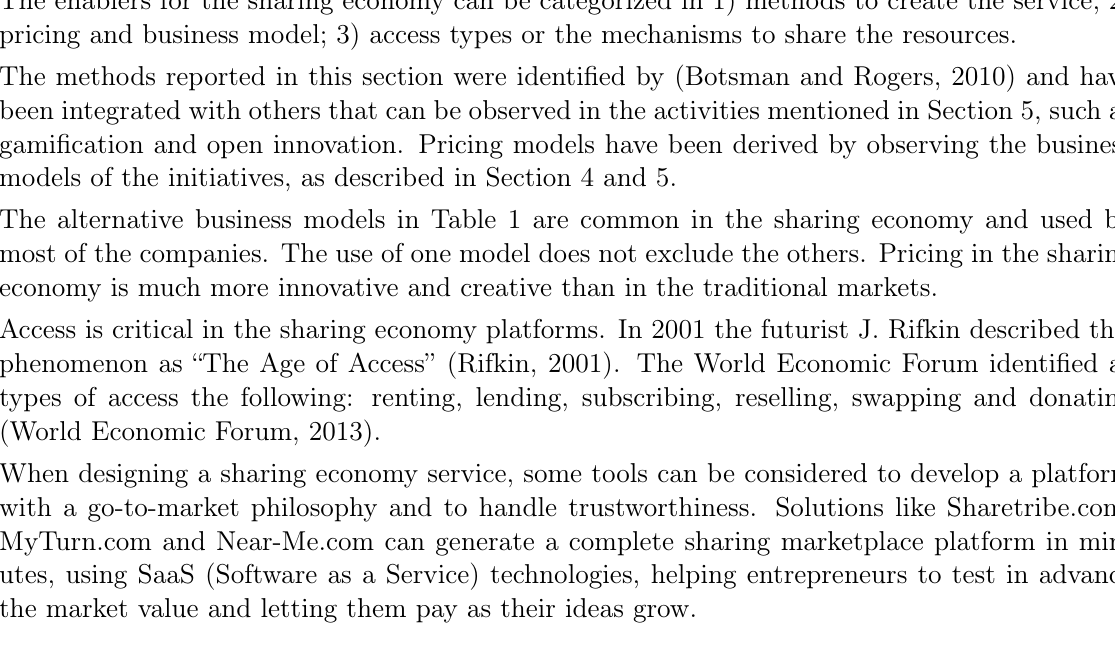
Table 1. The sharing economy methods and pricing / business models